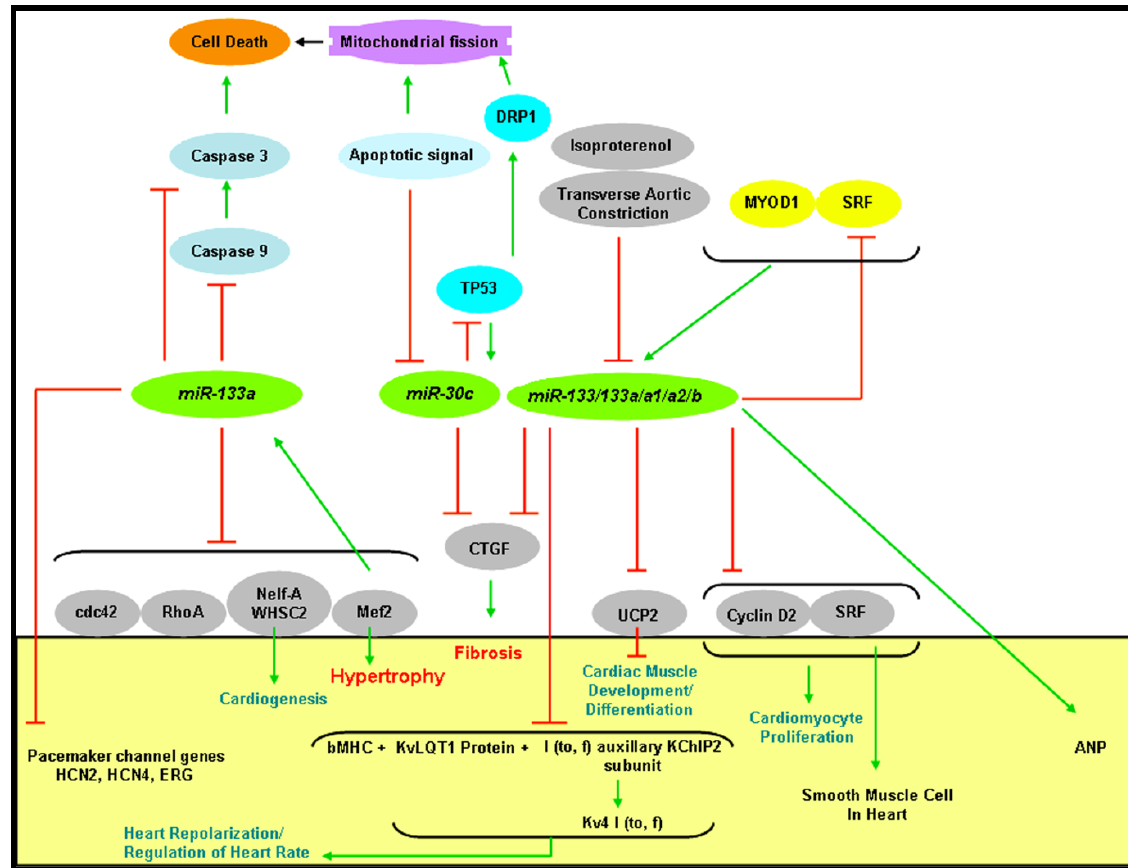
Figure 2: Proposed model of cardiomyopathy regulation by miR-30 and miR-133. This schematic representation depicts important signaling regulations between miR-30c/miR-133 and their upstream modulators and downstream targets, respectively. Abbreviations: DRP1: dynamin- related protein-1; TP53: tumor protein p53; CTGF: connective tissue growth factor; MYOD1: myogenic differentiation 1; SRF: serum response factor (c-fos serum response element-binding transcription factor); UCP2: uncoupling protein 2; KvLQT1: potassium voltage-gated channel, KQT-like subfamily, member 1; KChIP2: voltage-gated potassium Kv channel interacting protein 2; Kv4 I (to, f): Kv4-encoded fast transient outward (I ) K + channels; HCN2: potassium to hyperpolarization-activated cyclic nucleotide-gated channel 2; HCN4: potassium hyperpolarization-activated cyclic nucleotide-gated channel 4; ERG: ether-a-go-go-related K + channel gene; bMHC: beta myosin heavy chain; ANP: atrial natriuretic peptide; Mef2: myocyte enhancer factor-2; NelfA/WHSC2: negative elongation factor A/Wolf-Hirschhorn syndrome candidate 2; RhoA: Ras homolog gene family, member A, small GTPase protein; cdc42: cell division control protein 42. The symbols → and ┴ indicate activation/upregulation and inhibition/downregulation, respectively. Please refer to miReg for corresponding references of published